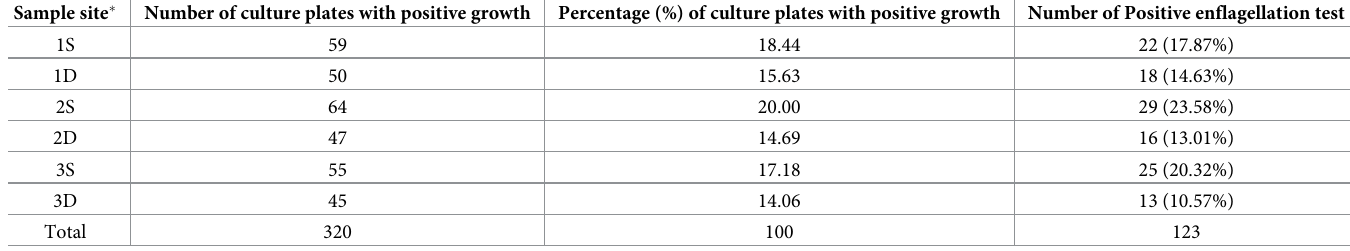
Table 2. Detected free living amoebae according to the sampling sites. Sample site